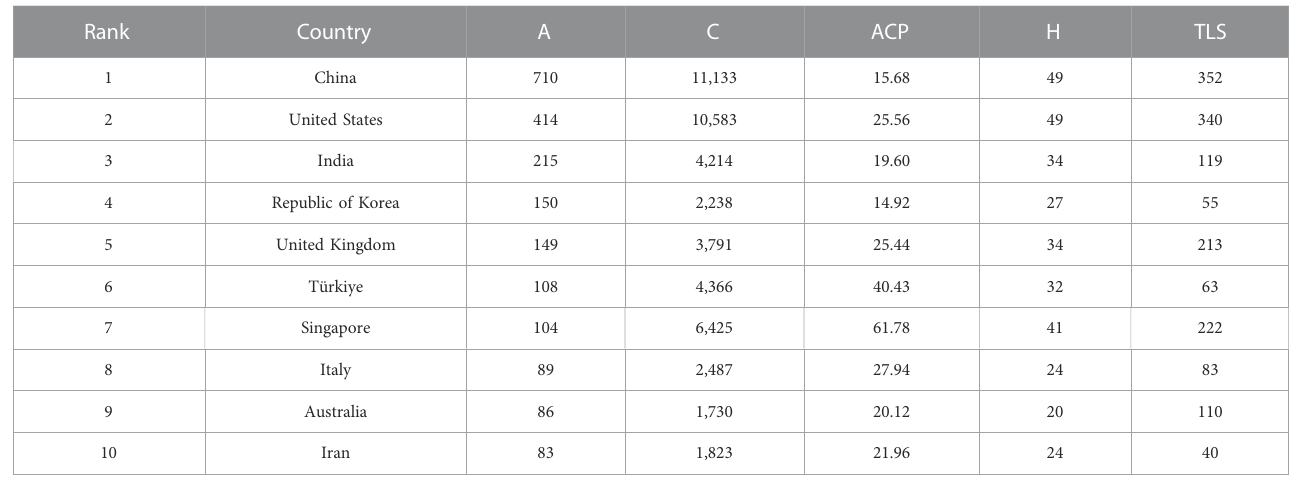
TABLE 1 Top 10 productive countries related to AI on